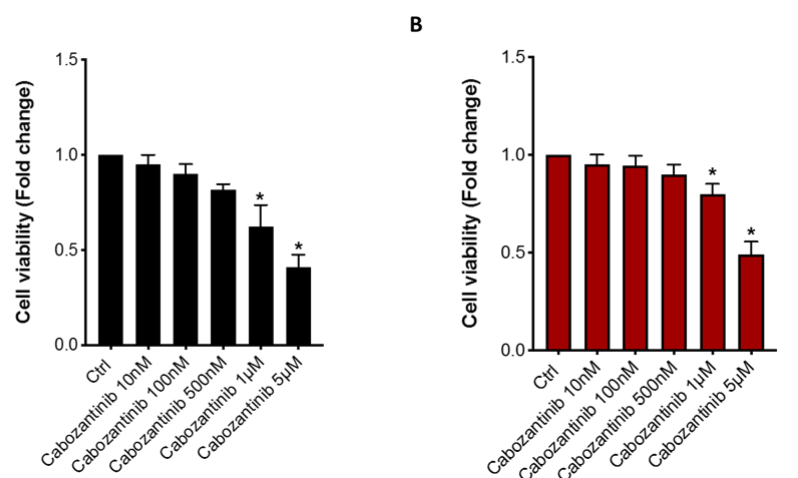
Figure 3. Antitumor effect of cabozantinib in RCC cells. Viability assay (MTT) of Caki-1 ( A ) and 786-O cells ( B ) after treatments with different doses of cabozantinib (10 nM, 100 nM, 500 nM, 1 μM and 5 μM). Data are expressed as the mean ± SD; * p ≤ 0.05.